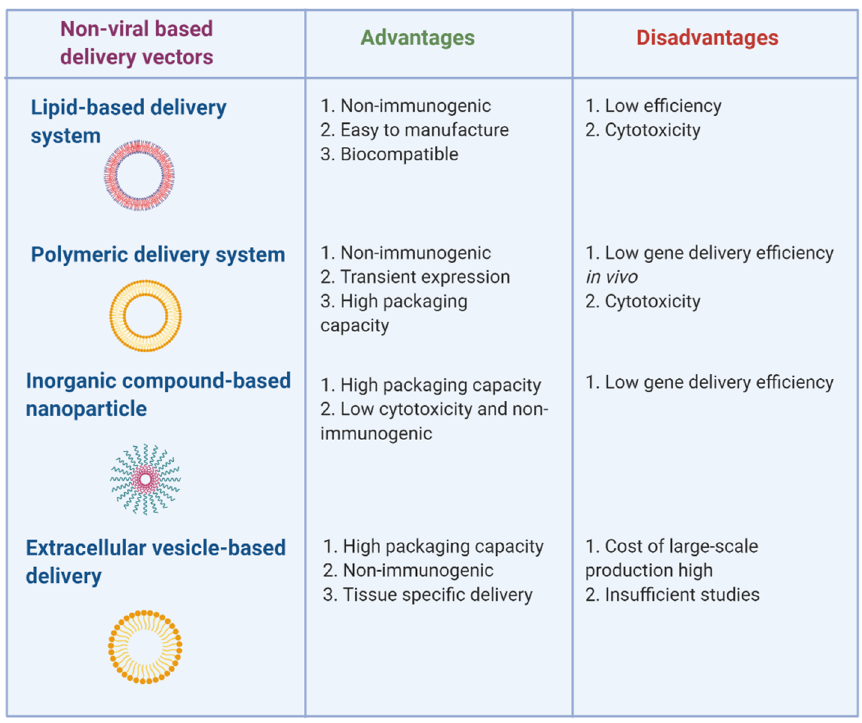
Figure 2. Strengths and weaknesses of non-viral miRNA delivery technologies. Lipid-, polymeric-, inorganic-, and exosome-based delivery methods are shown. Figure was created with BioRen- der.com.